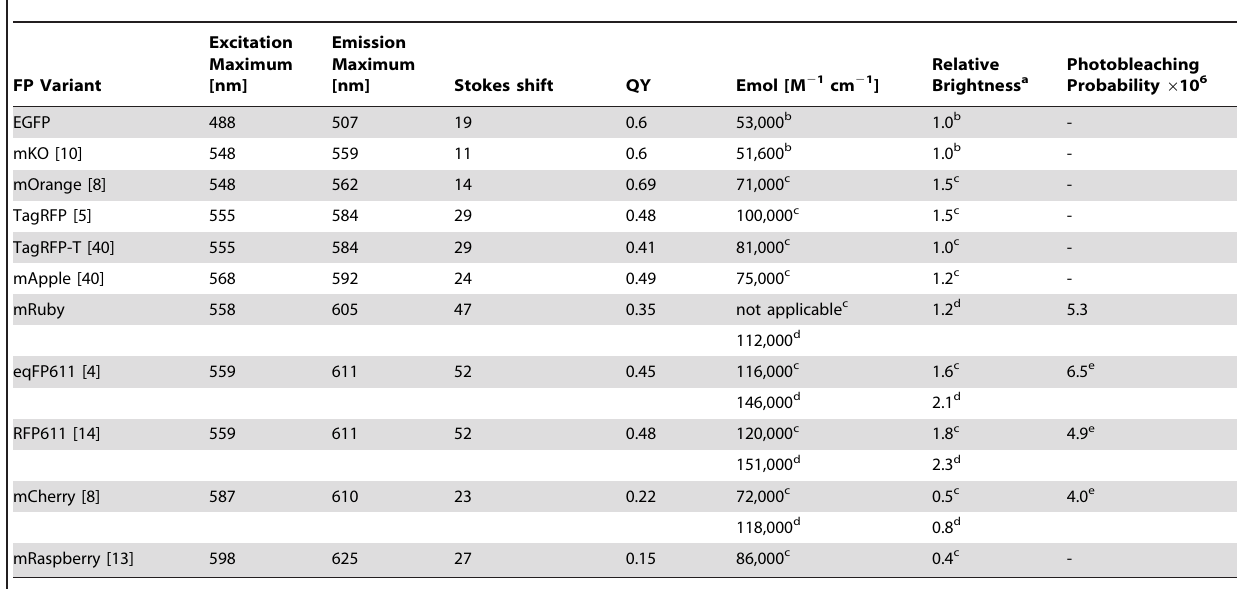
Table 1. Fluorescence properties of EGFP compared to mRuby, its predecessors and other monomeric fluorescent proteins emitting in the orange to red spectral